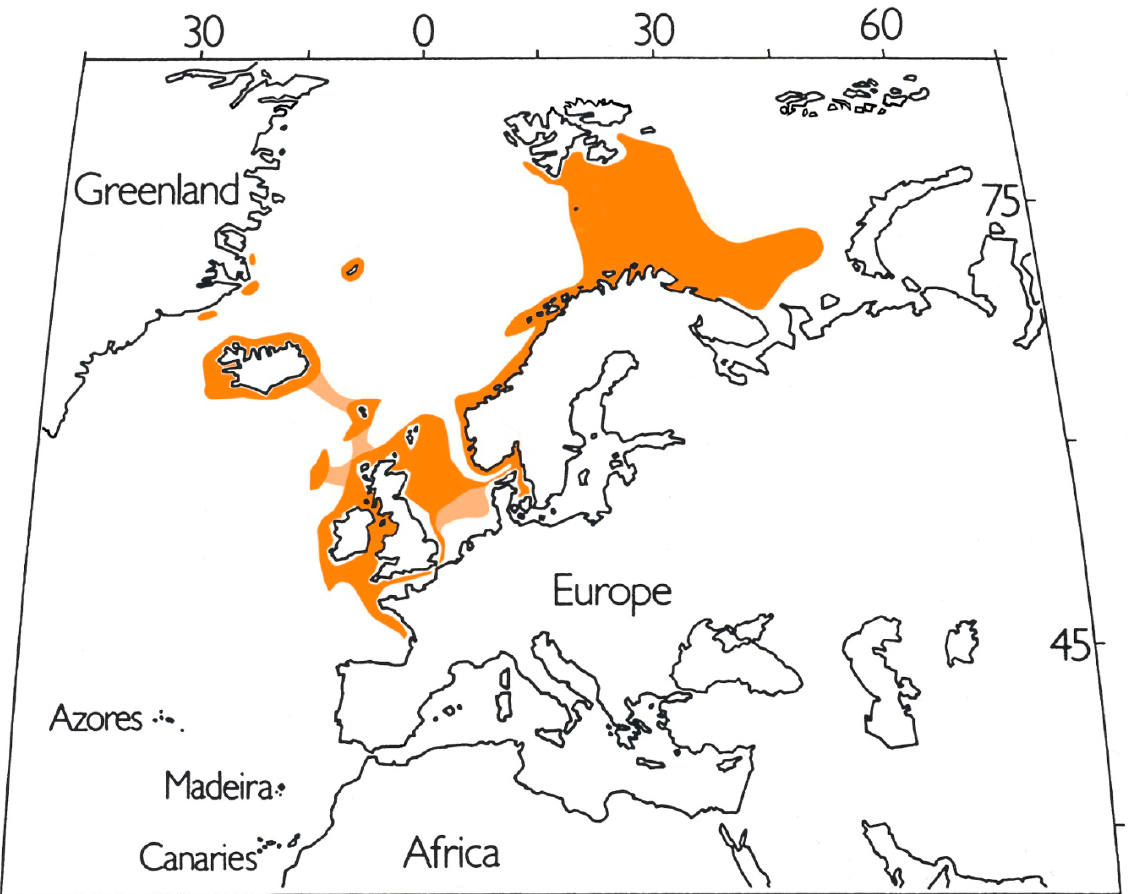
Figure 14. Present geographic distribution of Neocolliolus esmarkii . Lighter orange in the North Sea means lesser abundance. Lighter orange in the Atlantic Ocean means probable connection with more westerly occurrences.